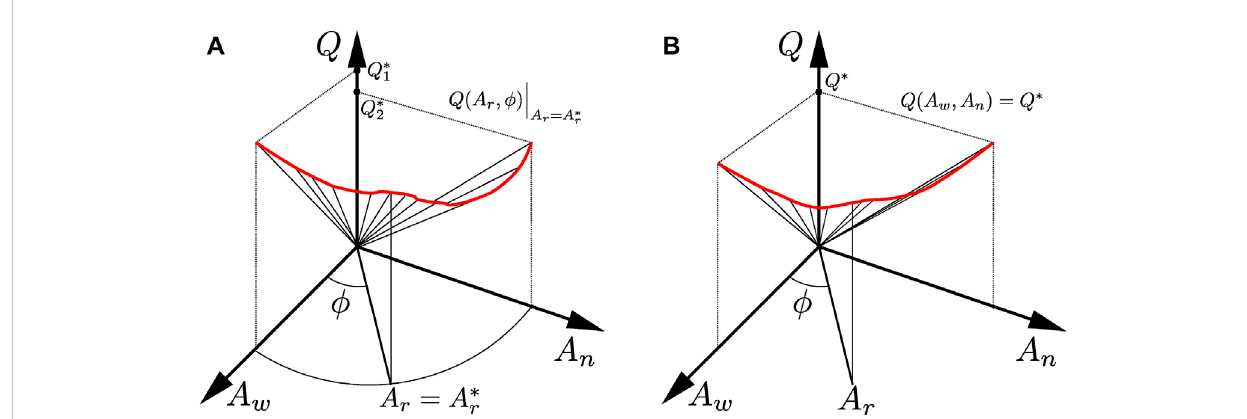
FIGURE 3 Geometrical meaning of the function Q being degree-1 Euler homogeneous in the extensive variables, meaning it ful fi ls equation (12), using polar coordinates.Wehereusethesamesymbol Q asbothavariableandafunction.Moving alongarayinthespacespannedbythevariables Q , A w and A n ,the volumetric fl ow rate increases linearly with the distance from the Q-axis. For a constant value A p r of the radial coordinate A r (A) or a constant value Q p of the volumetric fl ow rate (B) , the graph of Q appears as a “ crumpled ” cone originating at the origin, with the level set (shown in red) imagined as an “ edge ” . The level sets are different in the two cases. In particular, the volumetric fl ow rate will in (A) have different limiting values Q p single-phase fl ow of either the wetting or non-wetting fl